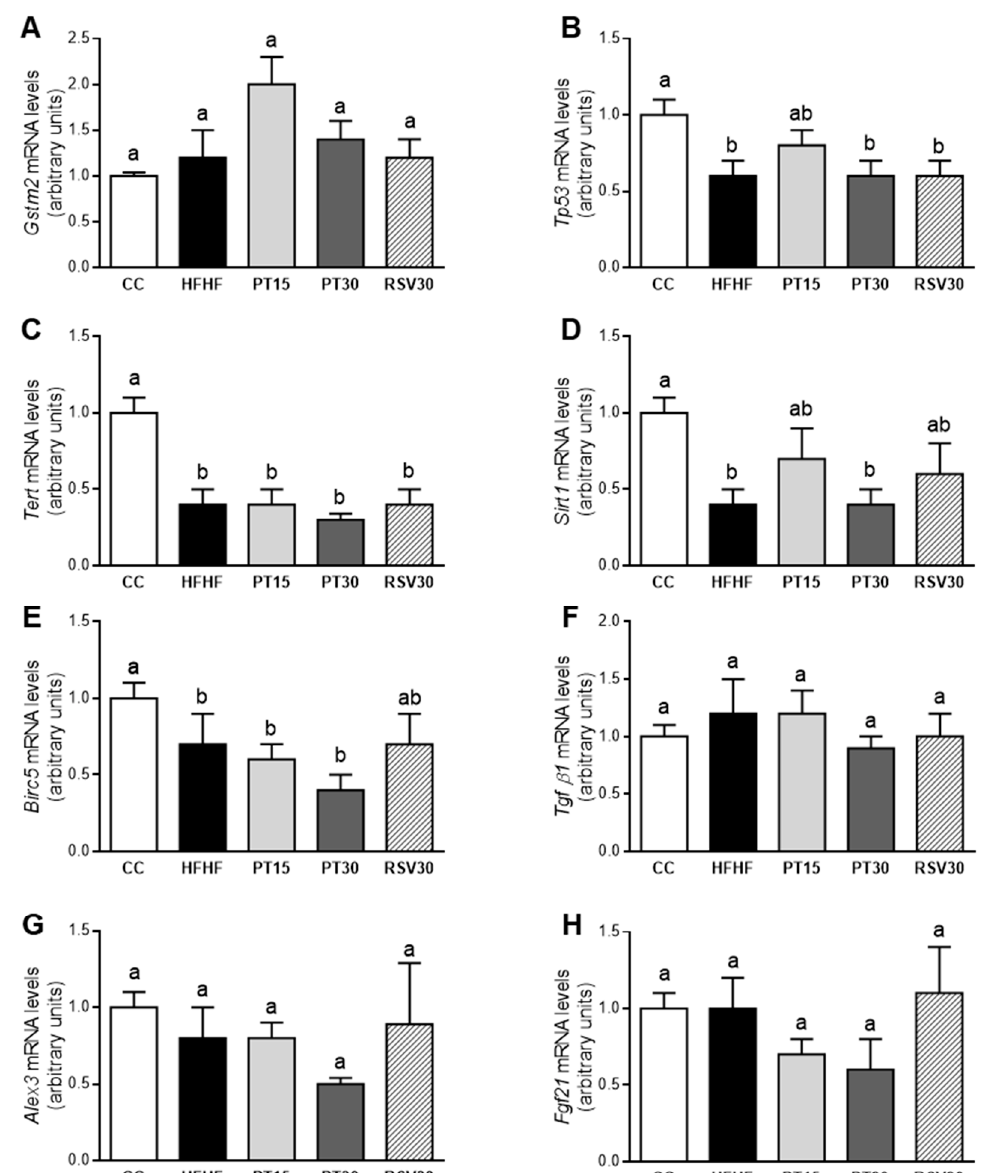
Figure 5. Gstm2 , Tp53 , Tert , Sirt1 , Birc5 , Tgf β 1 , Alex3 and Fgf21 mRNA levels in the livers from the rats fed with a control diet (CC group), a high-fat high-fructose diet (HFHF group), a high-fat high-fructose diet supplemented with pterostilbene at a dose of 15 mg / kg body weight / d (PT15 group), a high-fat high-fructose diet supplemented with pterostilbene at a dose of 30 mg / kg body weight / d (PT30 group) or a high-fat high-fructose diet supplemented with resveratrol at a dose of 30 mg / kg body weight / d (RSV30 group) ( A – H ). Values are presented as mean ± SEM. Bars not sharing common letters a,b are significantly di ff erent ( p < 0.05). Alex3 : ARM protein lost in epithelial cancers on chromosome X 3; Birc5 : survivin; Fgf21 : fibroblast growth factor 21; Gstm2 : glutathione s-transferase mu2; Sirt1 : sirtuin 1; Tert : telomerase reverse transcriptase; Tgf β 1 : transforming growth factor beta 1; Tp53 : tumor protein P53.